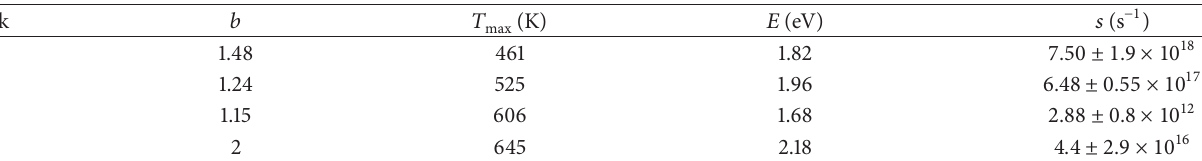
Table 1: Kinetics parameters obtained from the GCD analysis. In this table, 𝑏 is kinetics order, 𝑇 max the maximum of the TL peak, 𝐸 the activation energy of the trapping states associated with the peak, and 𝑠 the preexponential factor.